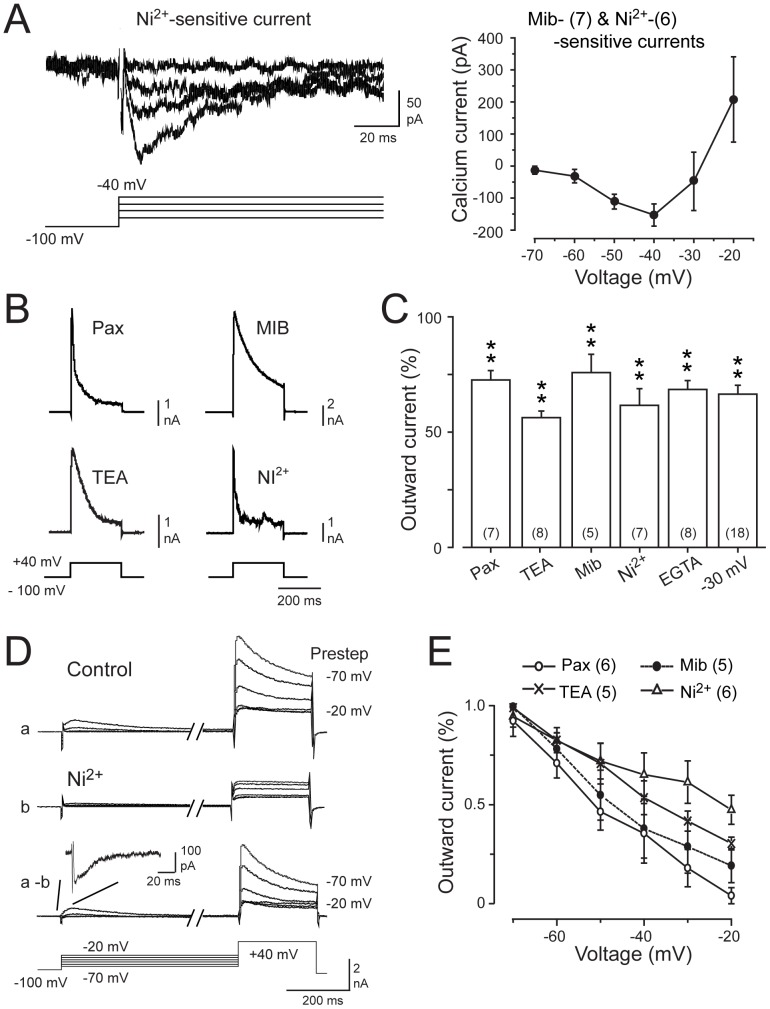
KCa1.1 channels are regulated by Cav3 calcium influx in MVN neurons.
A, Whole-cell recording of Ni2+ (300 µM) -sensitive Cav3 calcium current in the presence of 30 µM Cd2+ to block HVA calcium channels. At right is the current-voltage relationship for 1 µM mibefradil (Mib)- or Ni2+-sensitive currents (data pooled), revealing a LVA inward calcium current that peaks at −40 mV, and progressive activation of outward current at higher membrane voltages. B, Representative recordings of outward current sensitive to 1 µM paxilline (Pax) or 1 mM TEA to block KCa1.1 channels, or 1 µM mibefradil or 300 µM Ni2+ to block Cav3 channels reveal a similar rapid peak and decaying outward current. C, Bar plots of peak outward current evoked by a step from −100 mV to +40 mV. The average result of applying each of 1 µM mibefradil, 300 µM Ni2+, 1 mM TEA, 1 µM paxilline, or 10 mM internal EGTA is compared to the extent of KCa1.1 block by inactivating Cav3 channels by a prestep to −30 mV. Mean values were statistically different from original control values, but not from each other (one-way ANOVA F(5,47) = 1.63, P = 0.17). D, Representative outward current evoked by a step from −100 mV to +40 mV when preceded by preconditioning steps from −70 mV to −20 mV to evoke Cav3 channel inactivation. Shown are traces in control medium (a), after perfusing 300 µM Ni2+ (b), and difference currents (a–b). Inset shows an expanded view of the Cav3 current activated by an initial prestep to −30 mV. E, Mean plots of the voltage-dependence of outward current evoked from −100 mV to the indicated potentials and sensitive to each of the indicated blockers. Sample sizes in (A, C and E) are shown in brackets and capacitance artefacts in (A) were reduced digitally for display purposes.